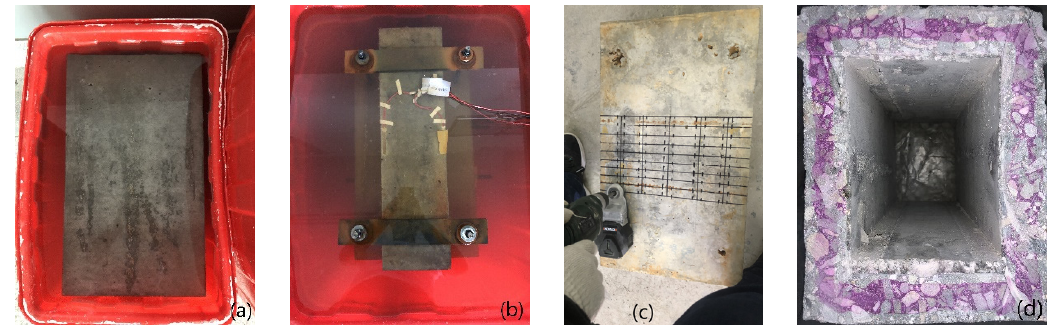
Figure 3. Corrosion process: ( a ) CH erosion; ( b ) ft + CH erosion; ( c ) Sample extraction; ( d ) Carbonation